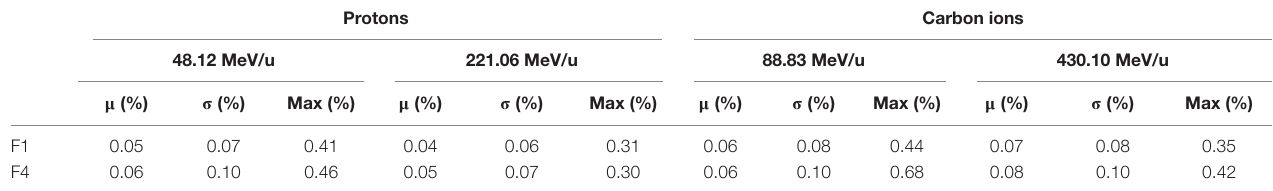
TaBle 3 | Primary particles energy spectra differences at the isocenter (absolute global differences with mean μ , sD σ , and maximum value) between the Ps and the Bl simulation approaches for both foci 1 and 4, in percentages compared to the maximum fluence and in a zone of interest with an fluence > 0.01% of the maximum